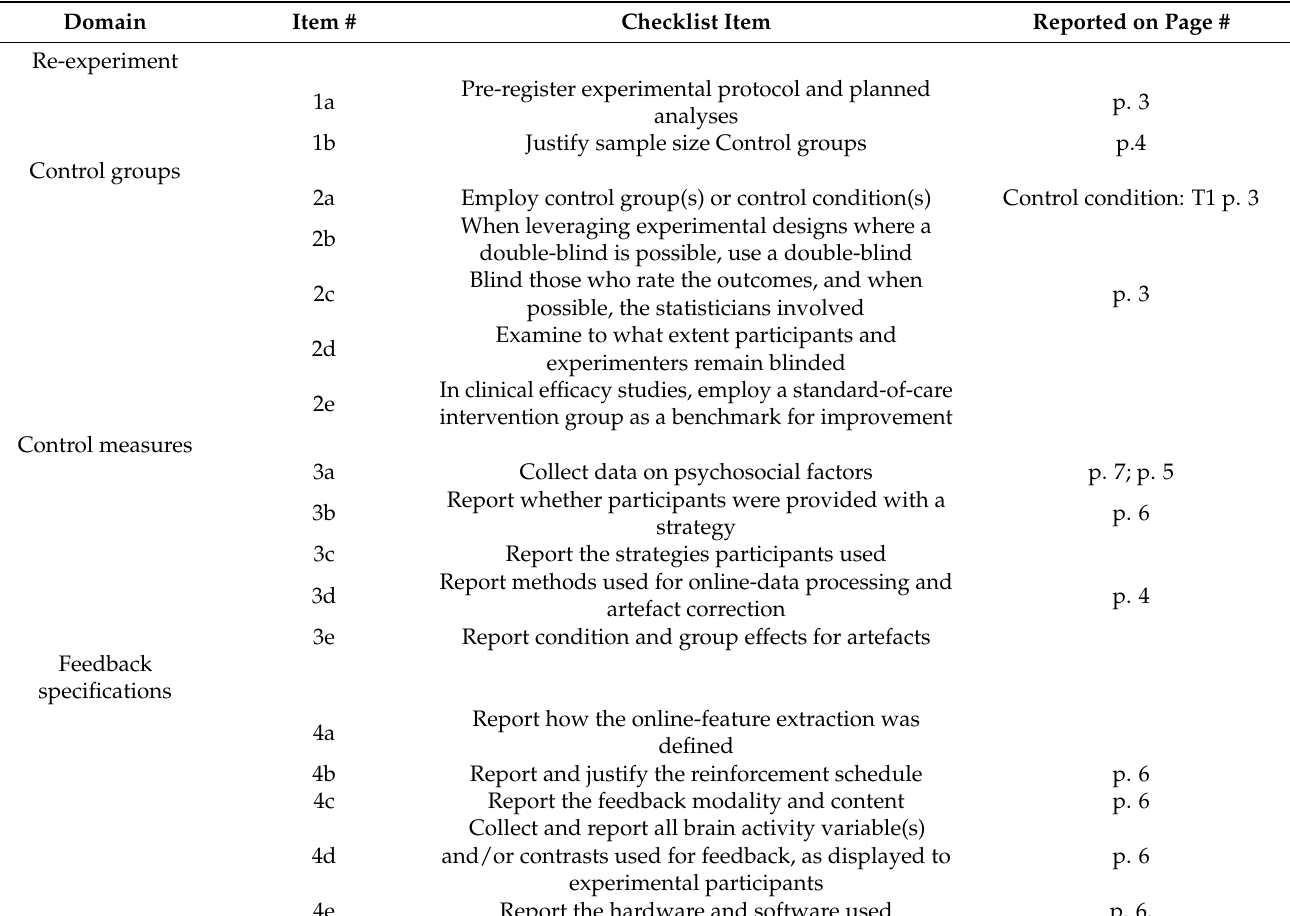
Table A1. CRED-nf best practices checklist